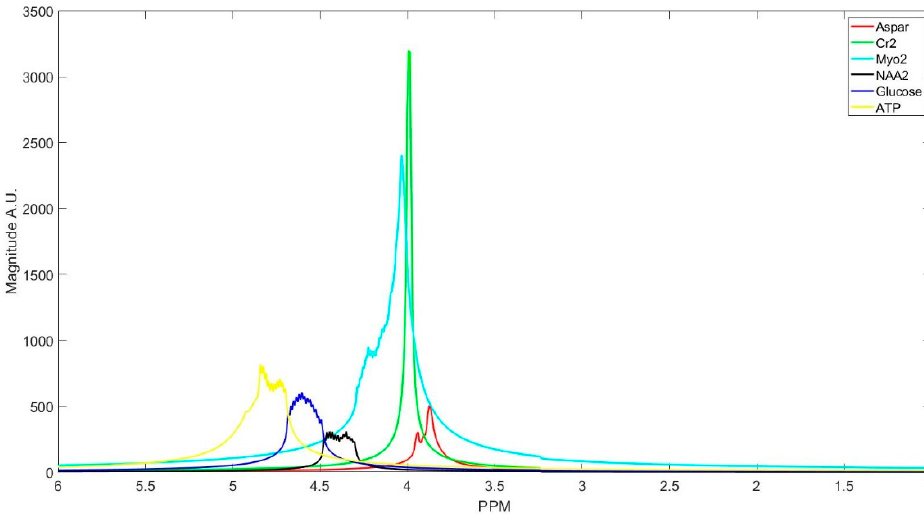
Figure A7. Clustered metabolites basis sets of group Figure 12. Clustered metabolites basis sets of group 3.